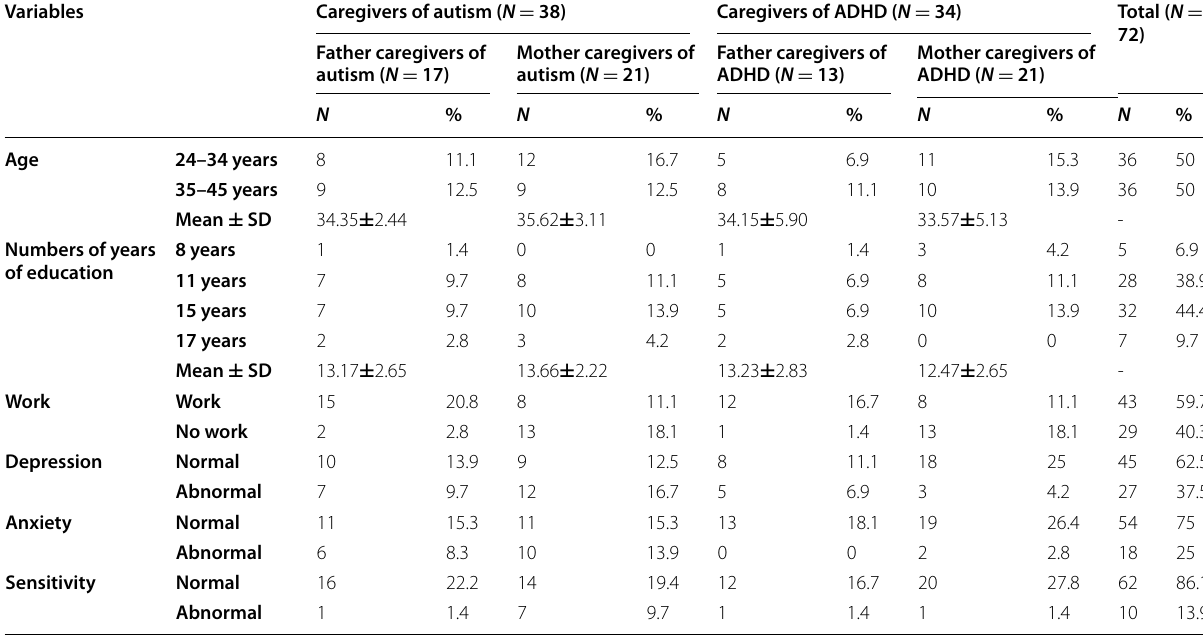
ADHD attention-deficit hyperactivity disorder Table 2 Comparison of affiliate stigma and associative stigma, burden scale, and anxiety, sensitivity, and quality of life between caregivers of autism and caregivers of ADHD